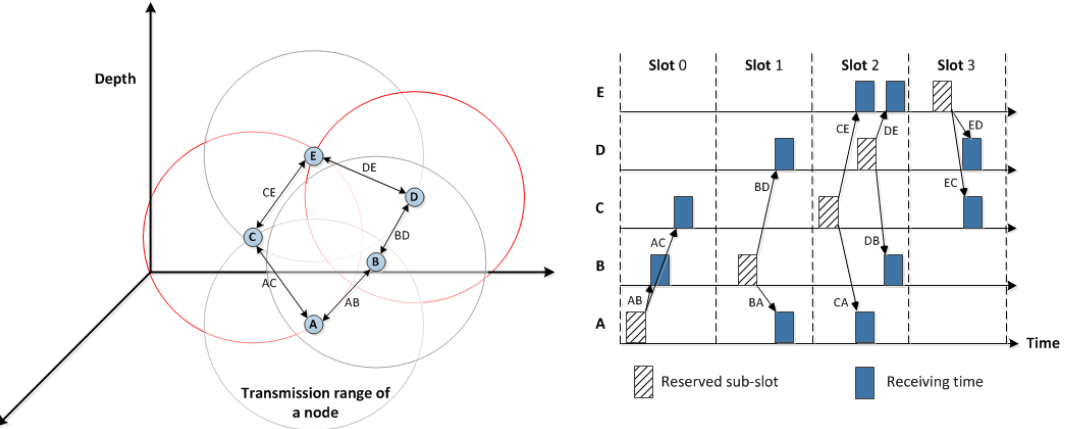
Figure 4. A specific scenario leading to a potential collision which has been addressed in